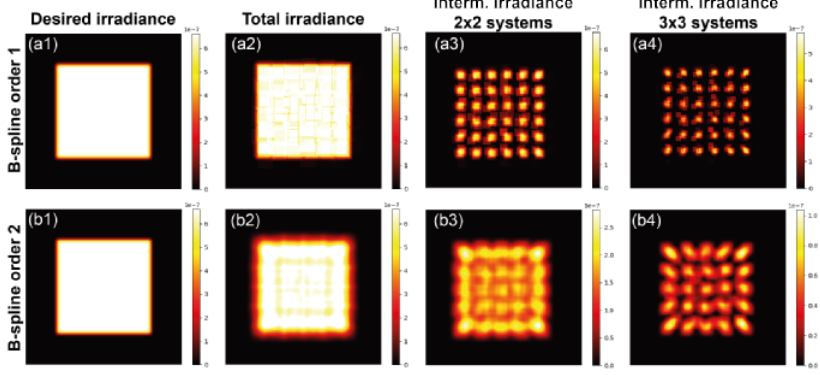
Figure 2. Results of the irradiance refinement: (a1) and (b1) show the desired irradiance distribution, (a2) and (b2) the obtained total irradiance distribution for B-spline of orders 1 and 2, (a3) and (b3) the resulting intermediate irradiance for 2x2 system, (a4) and (b4) intermediate irradiance for 3x3